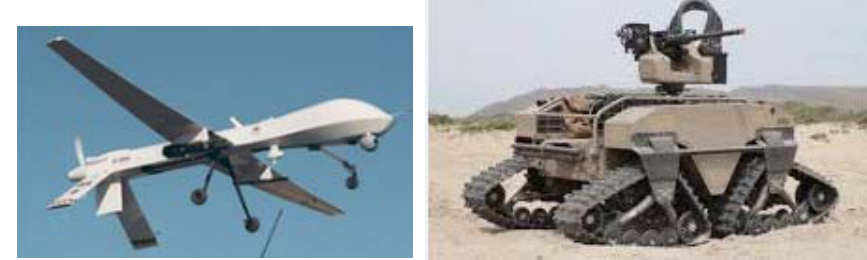
Figure 6. Autonomous fighter examples (MQ-1 Predator, M12). Source: www.kareneliot.de/